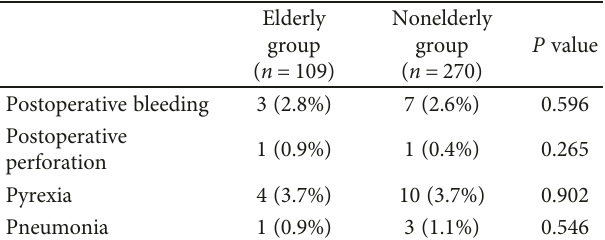
Table 3: The complications observed after ESD